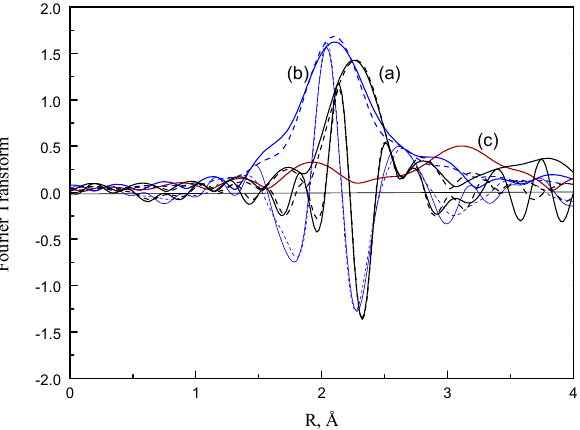
Figure 10. Comparison of the EXAFS Fourier transform (3.5 < k 3 < 12.0, Pt–O phase corrected) of residual EXAFS spectra between: (a) fresh Pt/ NaY-SiO 2 (black), (b) PtR (HF) (blue), (c) PtR (LF) (brown); magnitude (solid line), imaginary (dashed line). Table 3. Summary of EXAFS analysis results.